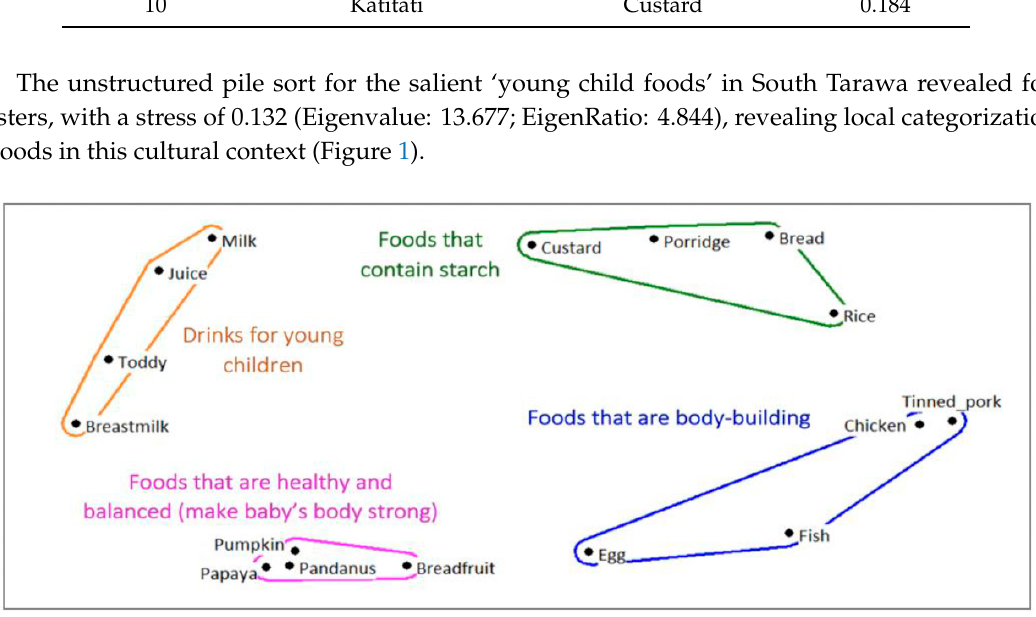
Figure 1. Multi-dimensional scaling map of pile sorting ‘young child foods’ in South Tarawa [urban].